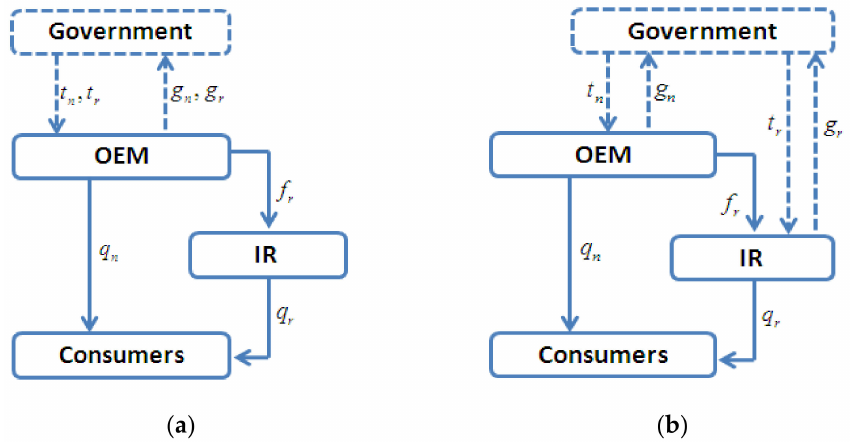
Figure 1. Problem structure: ( a ) Model C; ( b ) Model I.